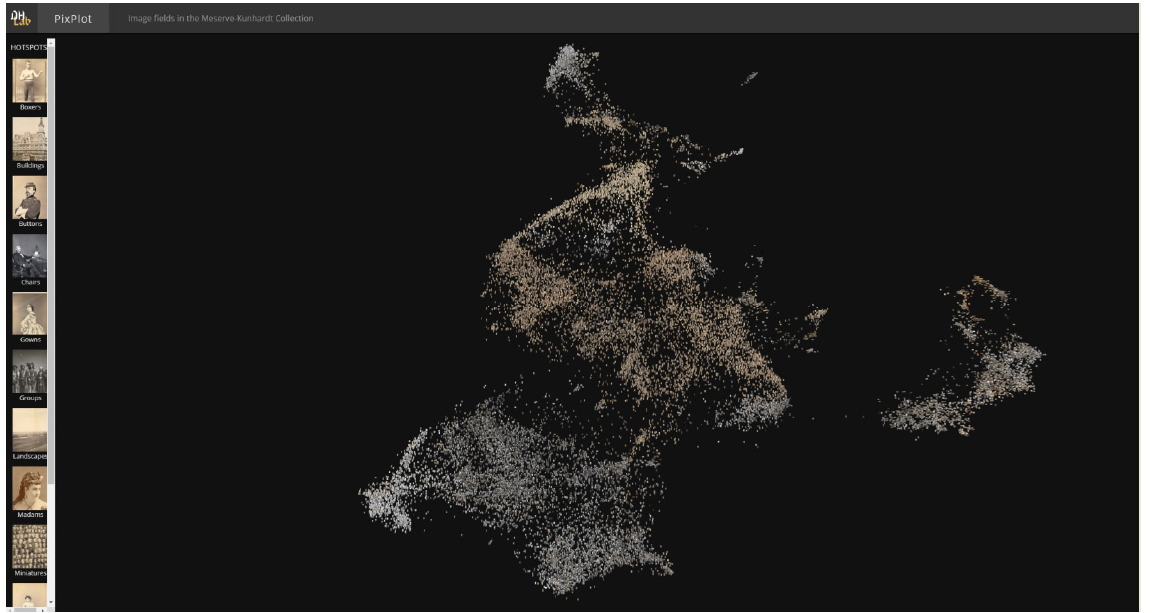
Figure 4. Two-dimensional manifold of image vector space with UMAP (Meserve Kunthardt Collection). Available on: https://s3-us-west-2.amazonaws.com/lab-apps/pix-plot/index.html (accessed: 28 July 2022) (screenshot).